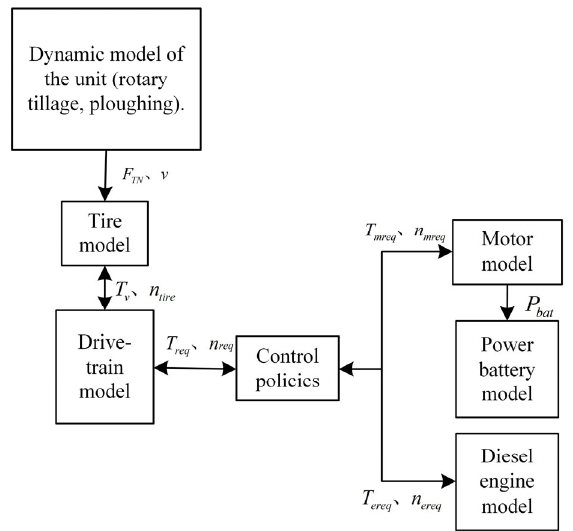
Figure 5. Schematic diagram of the whole machine simulation model.